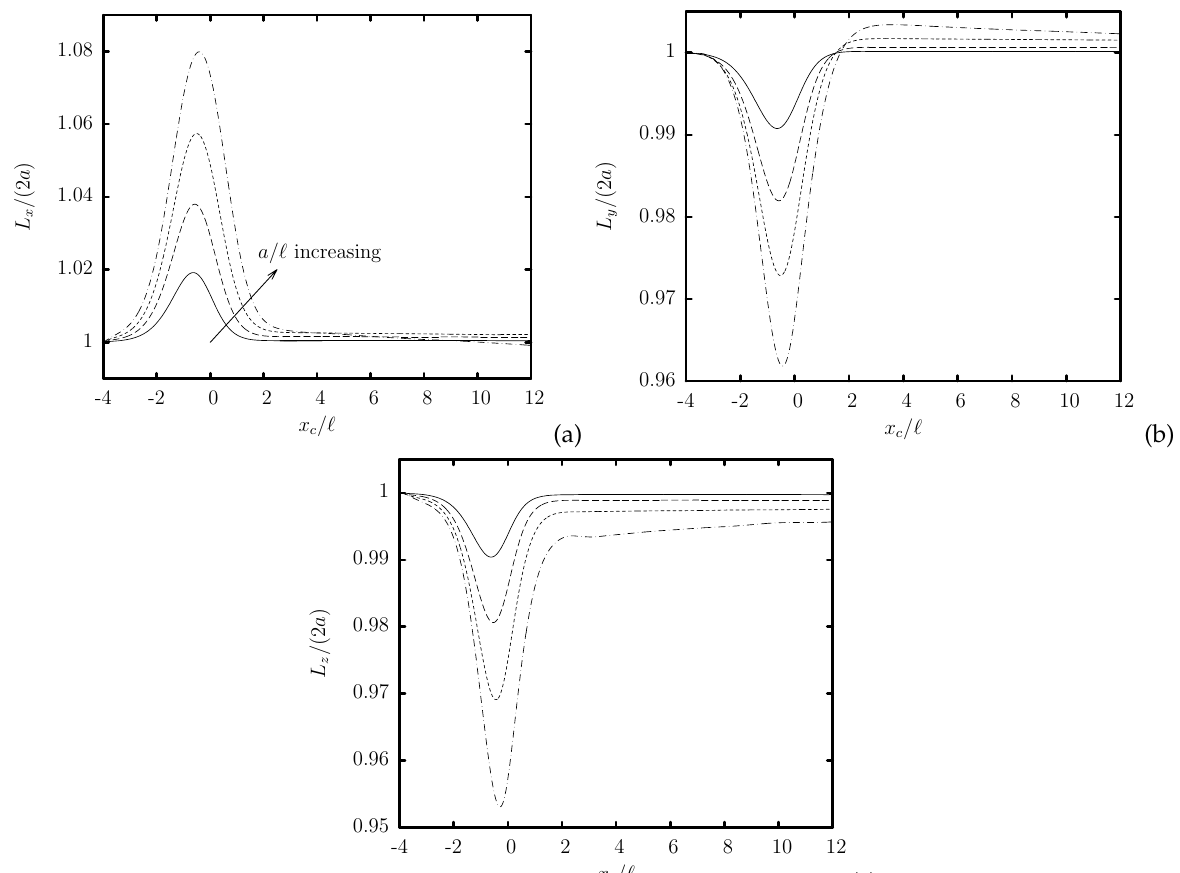
Figure 6. The capsule lengths as a function of the centroid x c , for a Skalak capsule with Ca = 0.1, C = 1, λ = 1, z 0 c / (cid:96) = 0.5 and capsule sizes a / (cid:96) = 0.2,0.4,0.6,0.8. ( a ) Length L x , ( b ) width L y and ( c ) height L z